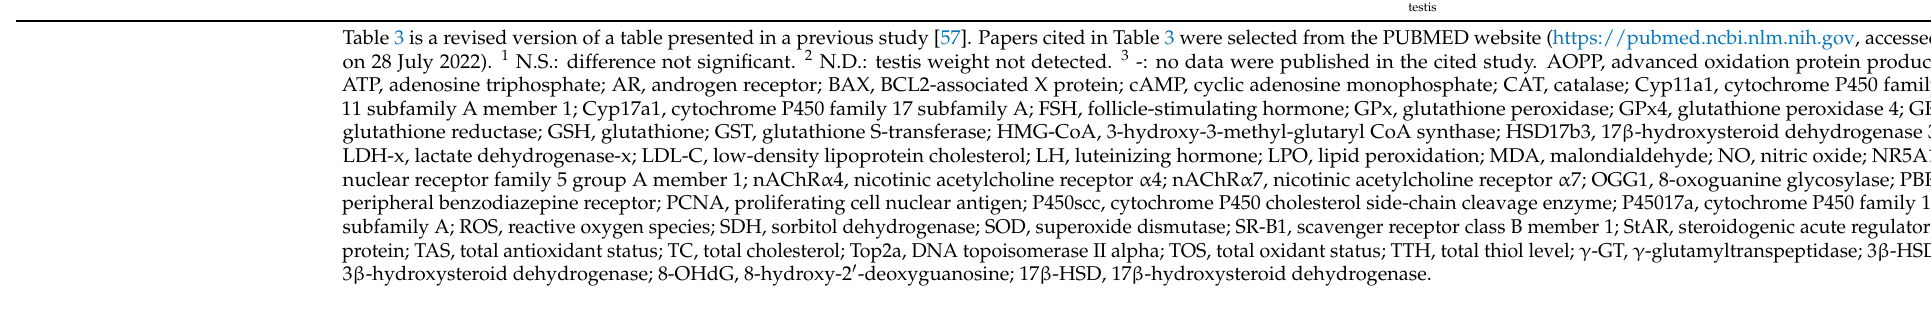
Table 3 is a revised version of a table presented in a previous study [57]. Papers cited in Table 3 were selected from the PUBMED website (https://pubmed.ncbi.nlm.nih.gov, accessed on 28 July 2022). 1 N.S.: difference not significant. 2 N.D.: testis weight not detected. 3 -: no data were published in the cited study. AOPP, advanced oxidation protein product; ATP, adenosine triphosphate; AR, androgen receptor; BAX, BCL2-associated X protein; cAMP, cyclic adenosine monophosphate; CAT, catalase; Cyp11a1, cytochrome P450 family 11 subfamily A member 1; Cyp17a1, cytochrome P450 family 17 subfamily A; FSH, follicle-stimulating hormone; GPx, glutathione peroxidase; GPx4, glutathione peroxidase 4; GR, glutathione reductase; GSH, glutathione; GST, glutathione S-transferase; HMG-CoA, 3-hydroxy-3-methyl-glutaryl CoA synthase; HSD17b3, 17 β -hydroxysteroid dehydrogenase 3; LDH-x, lactate dehydrogenase-x; LDL-C, low-density lipoprotein cholesterol; LH, luteinizing hormone; LPO, lipid peroxidation; MDA, malondialdehyde; NO, nitric oxide;